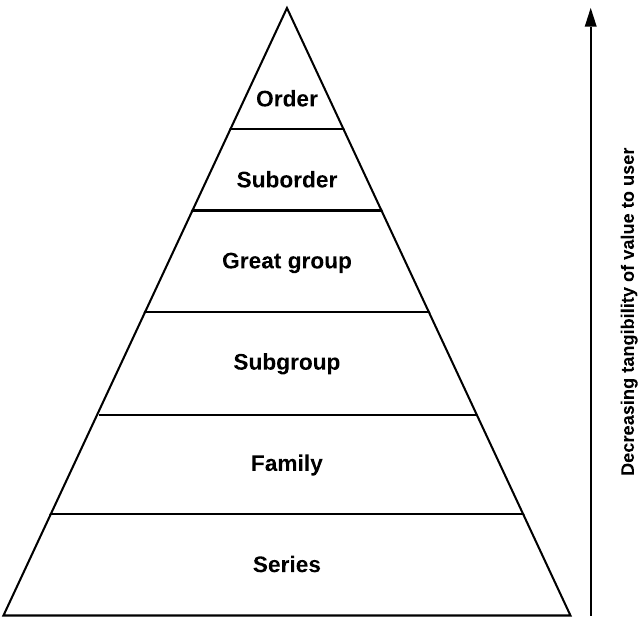
Figure 15. Taxonomic pedodiversity and tangibility of value to the user (adapted from Soil Survey Staff, 1999